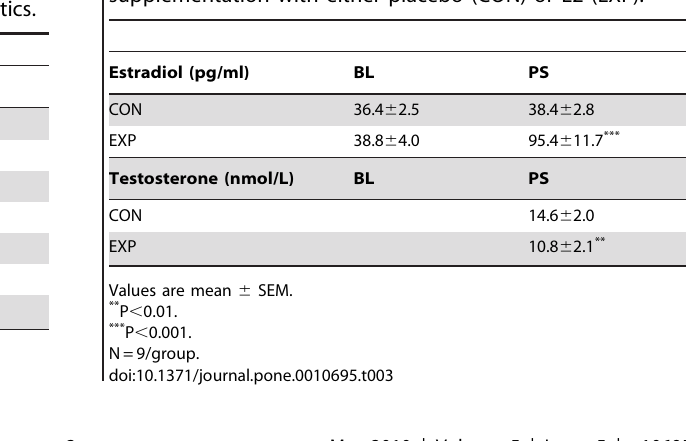
Gene Left Primer